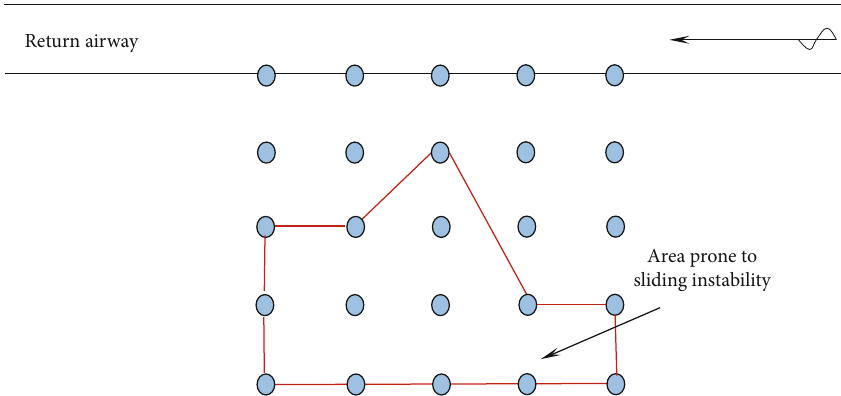
Figure 12: L = 200 m, H = 2 : 5 M of the face prone to instability